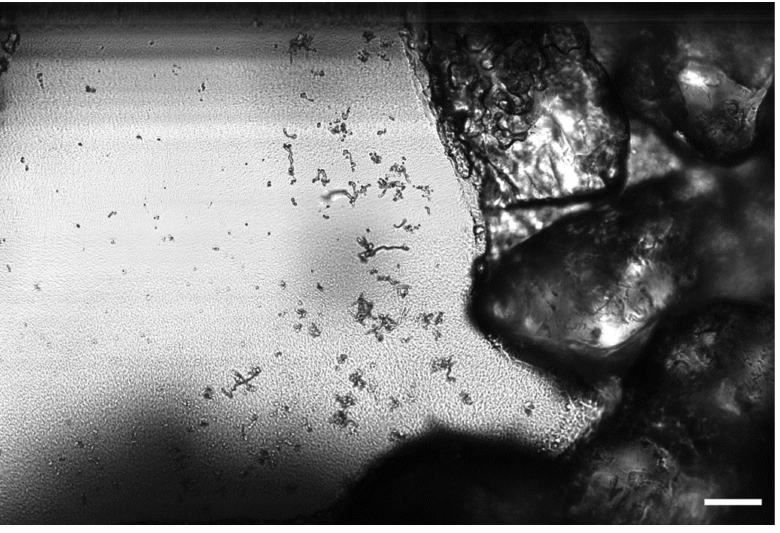
Figure 5. Methane hydrate halo and filaments on the floor of the glass cell on warming from − 16 to − 5 ◦ C in run 5. Scale bar: 50 µ